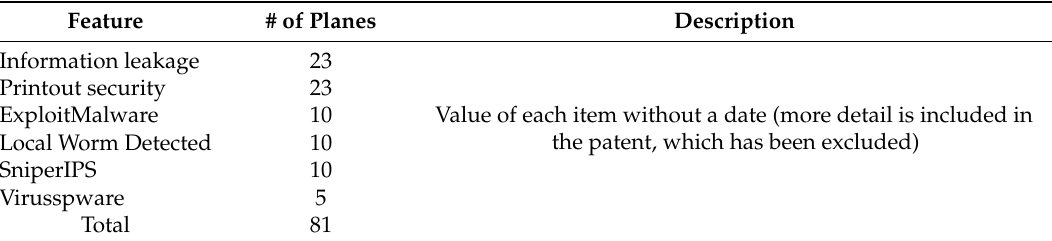
Table 3. Applied features